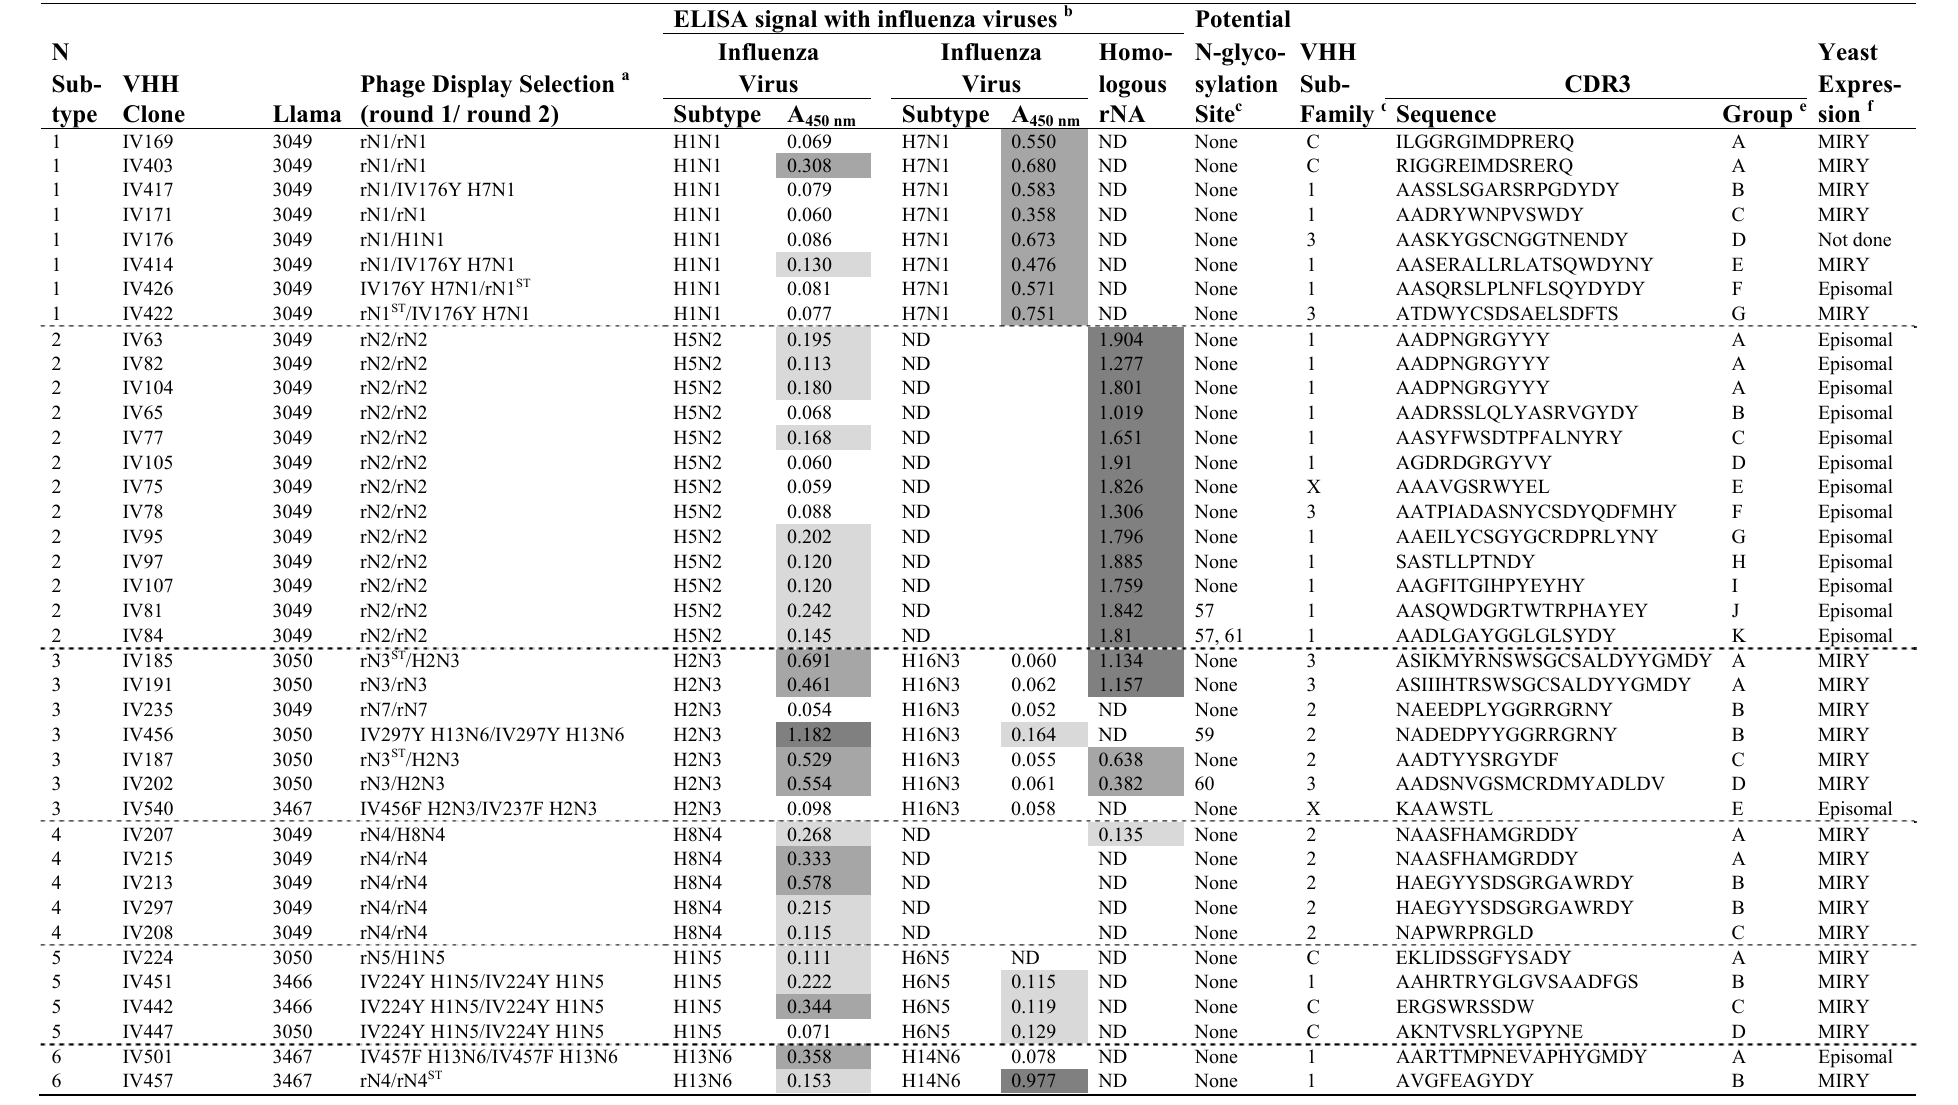
Table 4. Phage display selection history, antigen binding in ELISA and sequence characteristics of VHH clones selected for yeast